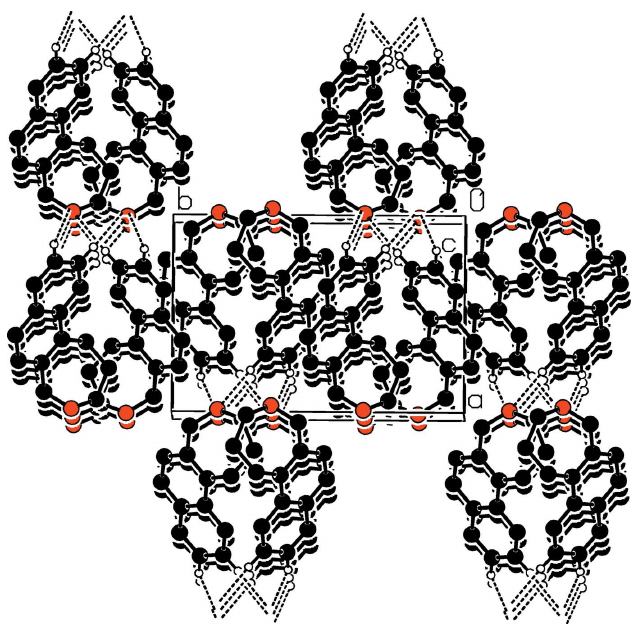
Figure 2 Part of the crystal structure with weak hydrogen bonds shown as dashed lines. Only H atoms involved in hydrogen bonds are shown.